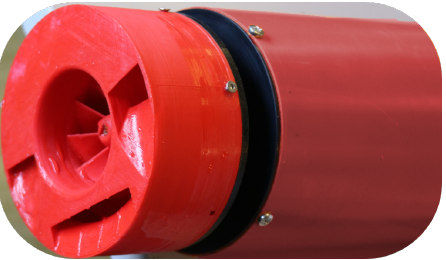
Figure 1. The modular pump-jet thruster for ASV operations in extremely shallow